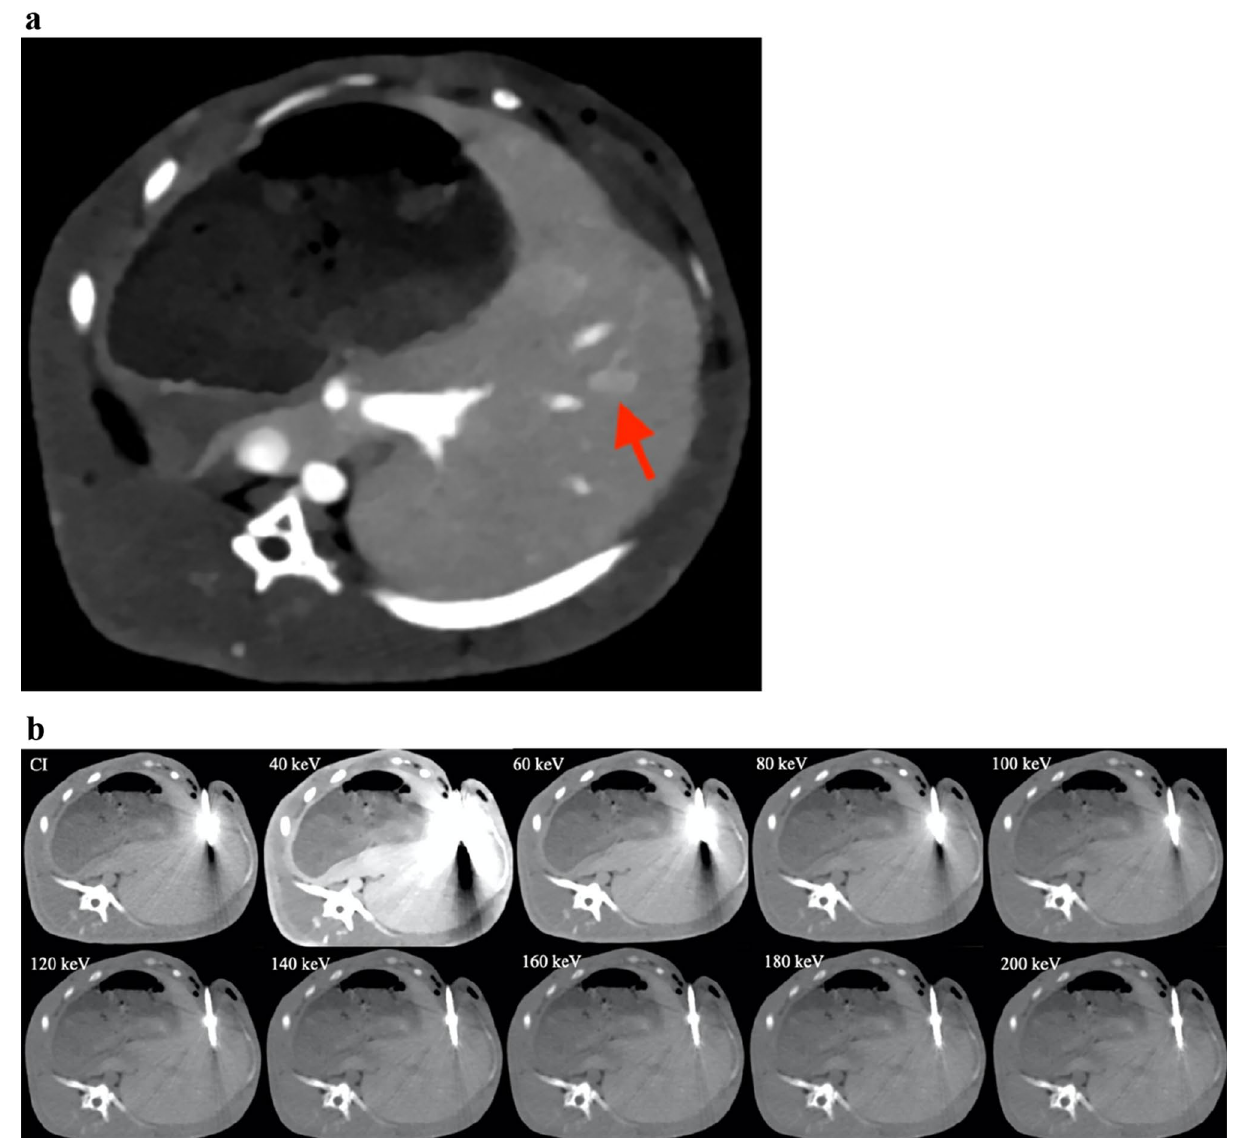
Figure 3. ( a ) Contrast-enhanced CT of VMIs at 40 keV showing the liver cancer (red arrow) in a rabbit. ( b ) Axial plain CT in the same rabbit with MWA treatment. Images were reconstructed as conventional images (CIs) and as different energy levels of virtual monoenergetic images (40 keV, 60 keV, 80 keV, 100 keV, 120 keV, 140 keV, 160 keV, 180 keV and 200 keV, window width/level: 350/60 for all